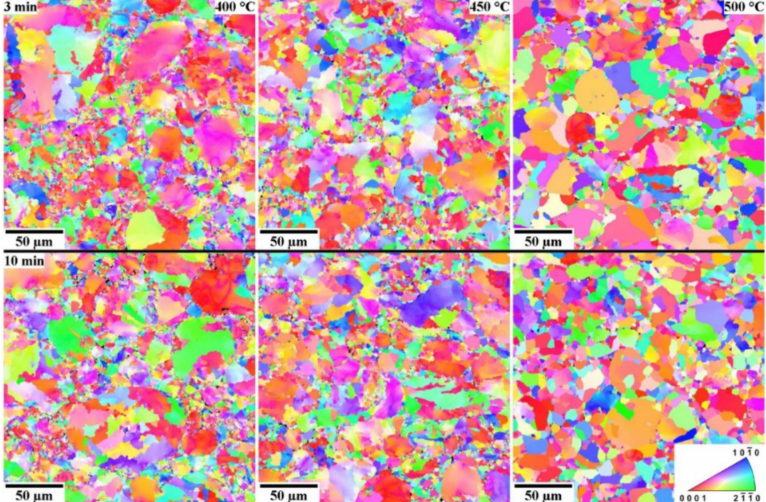
Figure 6. EBSD image of Mg-based composite at different sintering temperature and time